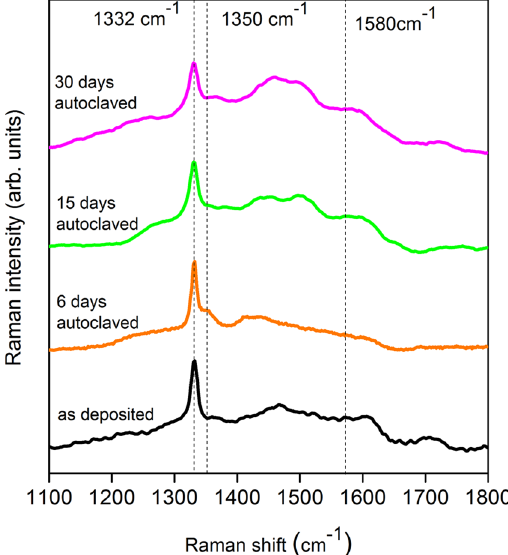
Figure 4. Measured 488 nm Raman spectra of 300 nm thick NCD layers on ZIRLO tubes, as deposited and after 6, 15 and 30 days of exposure to hot water at 360 °C. The 1332 cm − 1 peak is typical of diamond. The broad band visible at 1400–1550 cm − 1 is a signature of amorphous carbon located within the grain boundaries, the band at ~1580 cm − 1 was assigned to graphite, and the ~1620 cm − 1 peak was attributed to the presence of “graphite-like” disordered